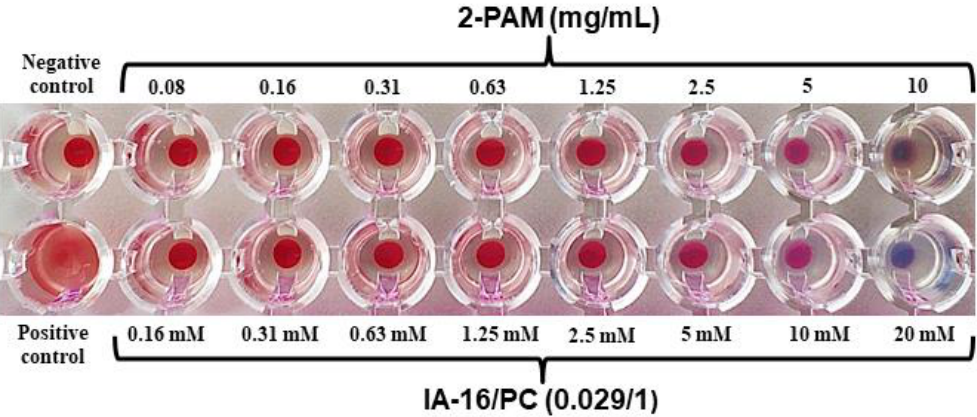
Figure 6. Photograph of microplate wells containing blood samples with addition of free 2-PAM and IA-16/PC formulation, C (2-PAM) = 10 mg/mL.